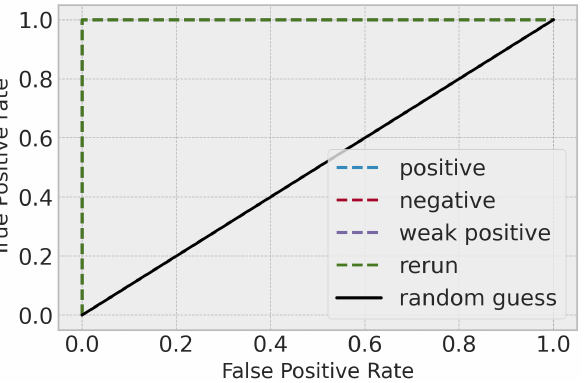
Figure 6. ROC curves demonstrate the probability curve between true positive rate and false positive rate. Note that the curves of all classes are the same and overlap on the